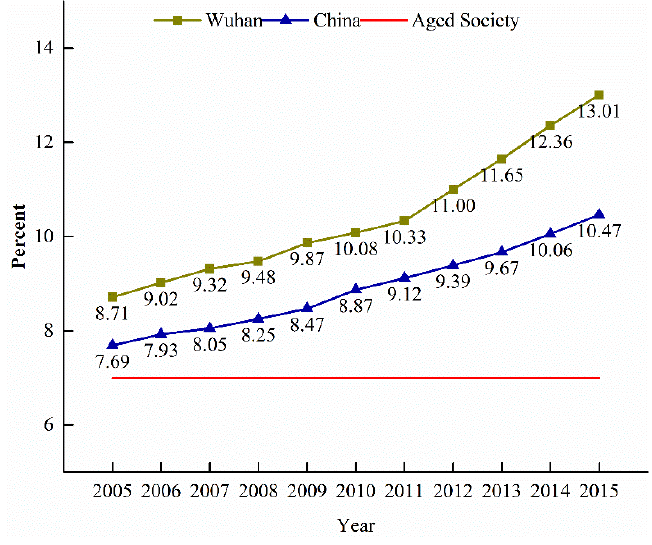
Figure 1. The ratio of 65+ years old, China and Wuhan, 2005–2015. Data source: extracted from the National Bureau of Statistics website and Wuhan Statistical Yearbook.